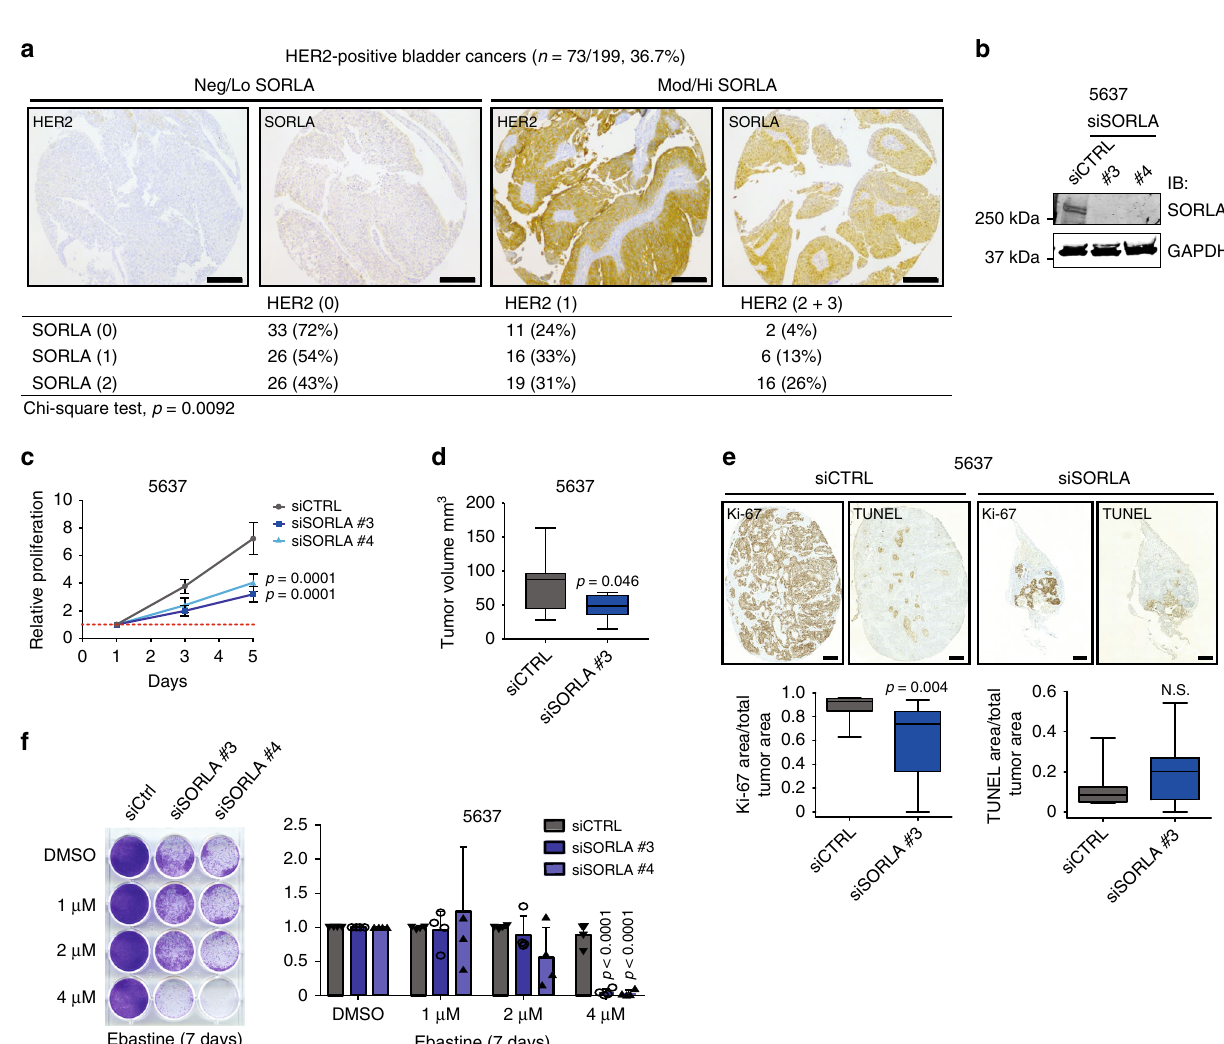
Fig. 6 SORLA expression correlates with HER2 and promotes tumorigenesis in bladder carcinoma. a Immunohistochemical staining of a bladder cancer TMA and correlation analyses of SORLA and HER2 levels. Numbers indicate staining intensity, 0 = negative, 1 = weak, 2 = moderate, 3 = high. b Western blot analysis of SORLA levels in siCTRL and siSORLA (siSORLA#3, siSORLA#4) 5637 bladder cancer cells. GAPDH is a loading control. c Analysis of siCTRL and siSORLA (siSORLA#3, siSORLA#4) 5637 cell proliferation (mean ± s.d; n = 4 independent experiments; statistical analysis: two-way ANOVA). d Analysis of tumour growth of subcutaneously injected 5637 cells, with transient SORLA (siSORLA #3) or scramble (siCTRL) silencing, at day 29 in nude mice ( n = 9 siCTRL and 10 siSORLA mice; statistical analysis: unpaired Student ’ s t test). e Ki-67 and TUNEL staining of tumour samples prepared as described in d and quanti fi cations displayed as box plots ( n = 9 siCTRL and 10 siSORLA mice; statistical analysis: Mann − Whitney test). f Colony formation assay with SORLA-silenced and control-silenced 5637 cells treated with different concentrations of ebastine for 7 days. Quanti fi cation of con fl uency was performed using ImageJ Colony Area Plug-in 49 . Results are shown as mean ± s.d. ( n = 4 independent experiments; statistical analysis: unpaired Students t test). Scale bars: 200 µ m ( a ), 500 µ m ( e ). Box plots represent median and IQR and whiskers extend to maximum and minimum